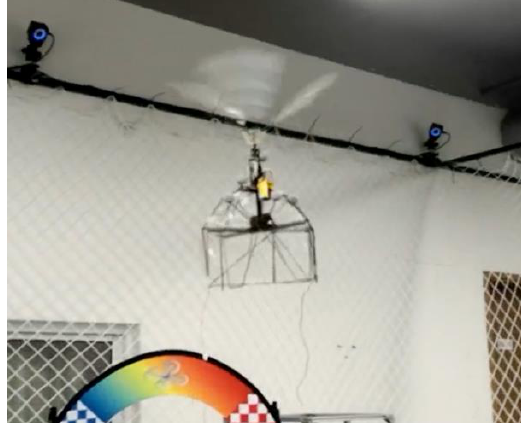
Figure 2. The lift generation system and the active flapping, passive rotation, and passive torsion of the wings.